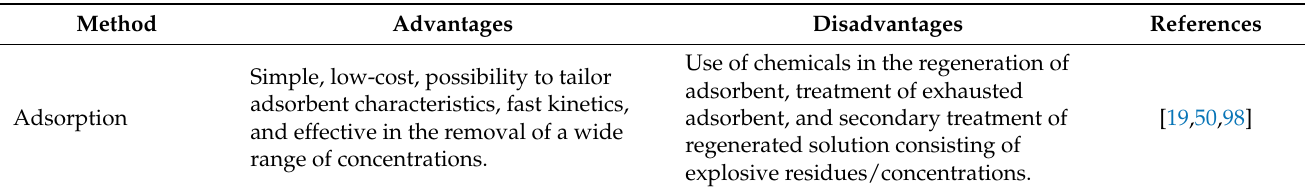
Table 5. Advantages and disadvantages of HMX treatment